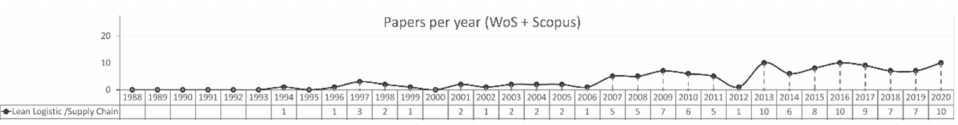
Figure 7. Lean logistics and lean supply chain